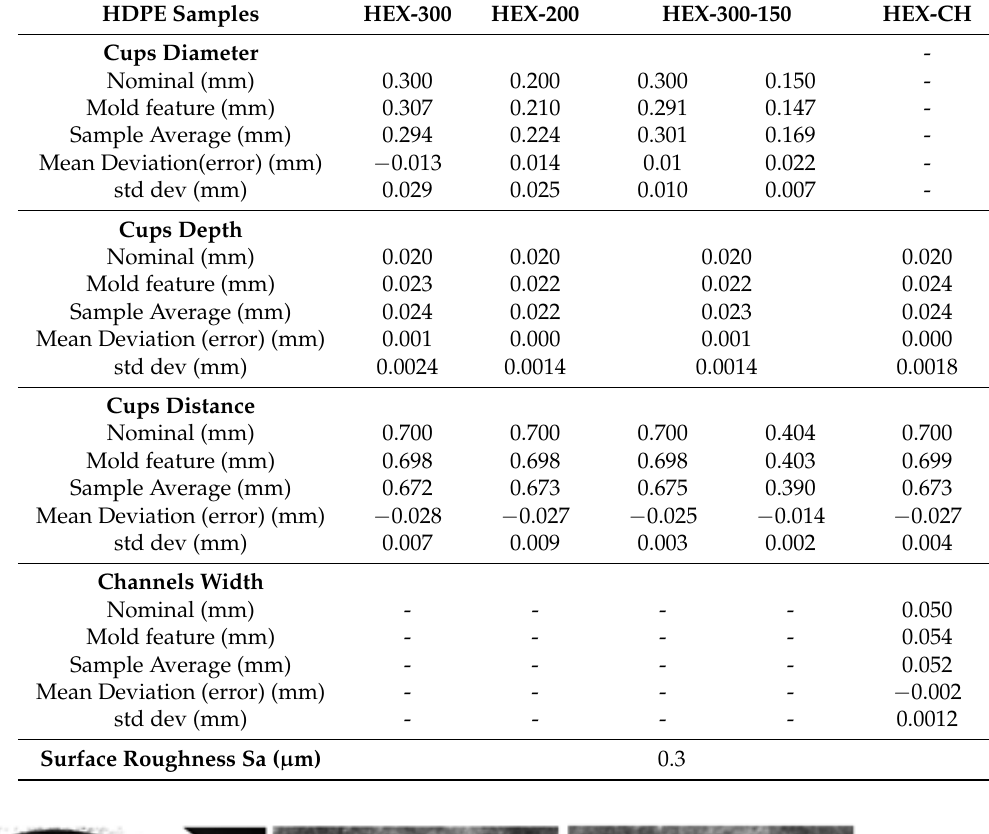
Table 7. HDPE sample features measurements.